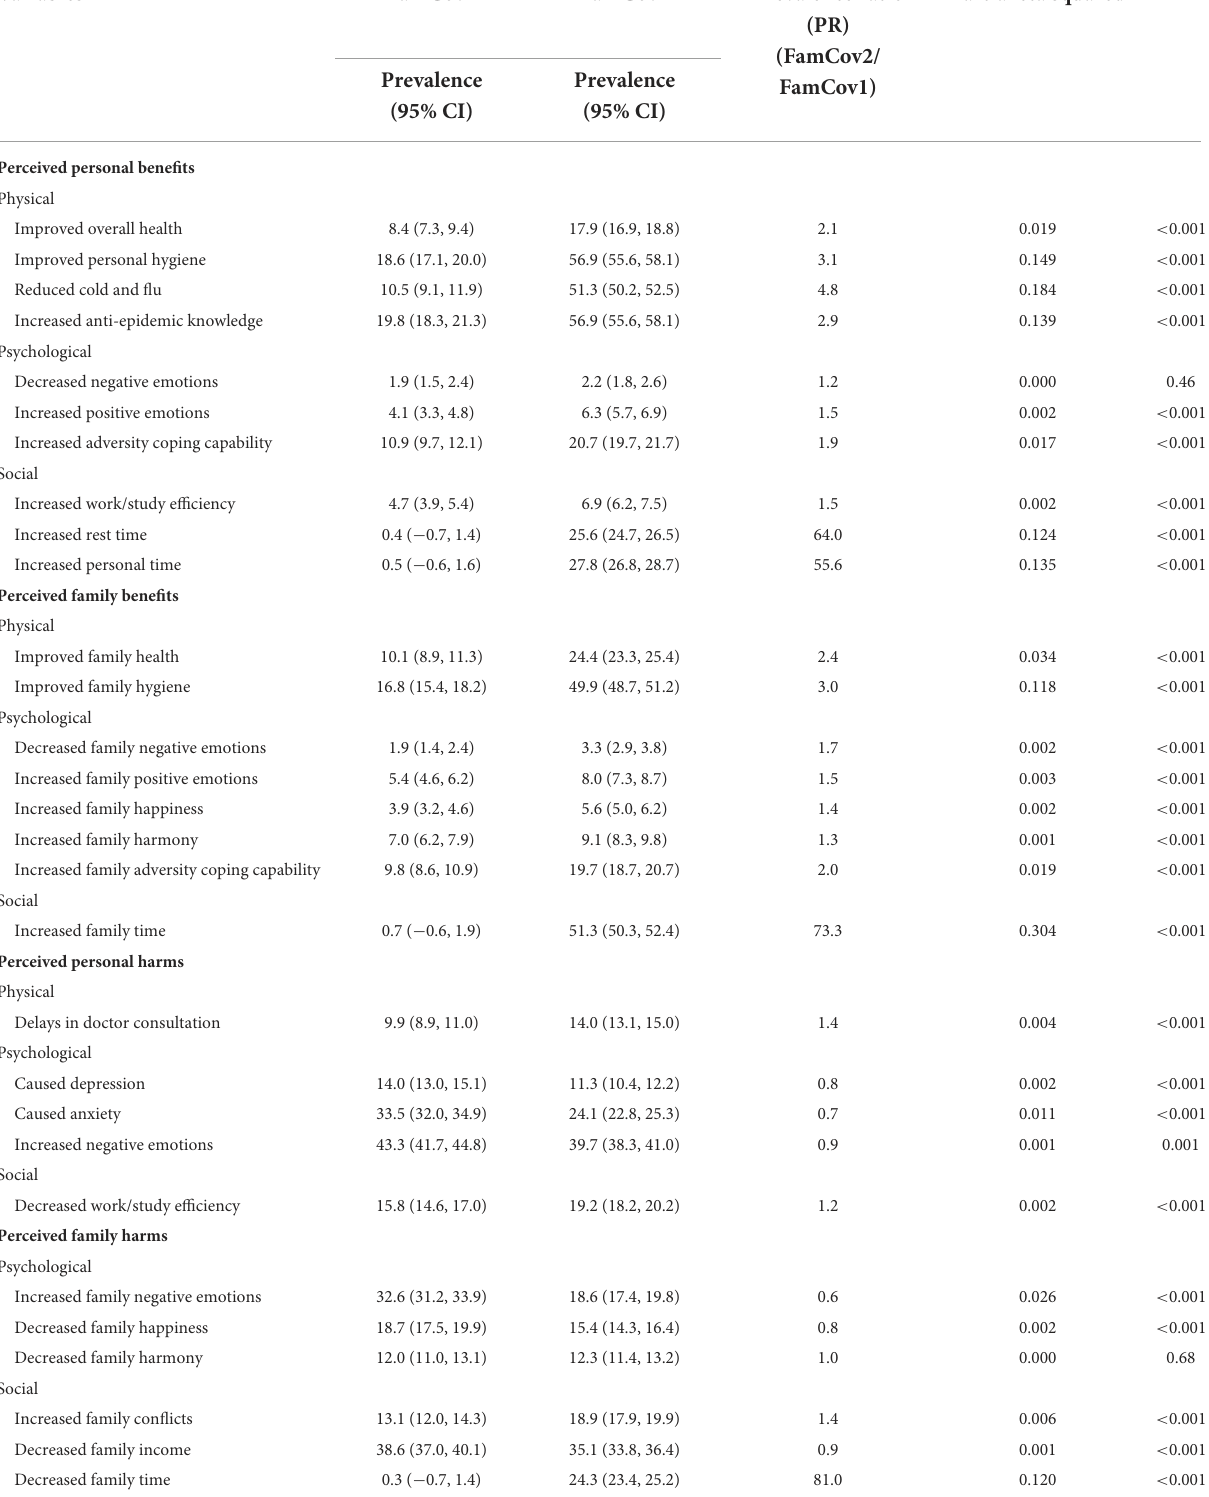
TABLE 2 Sex- and age-adjusted weighted prevalence (95% confidence intervals) of perceived benefits and harms in FamCov1 (May 2020) and FamCov2 (March 2021) surveys. Variables FamCov1 FamCov2 Prevalence ratio